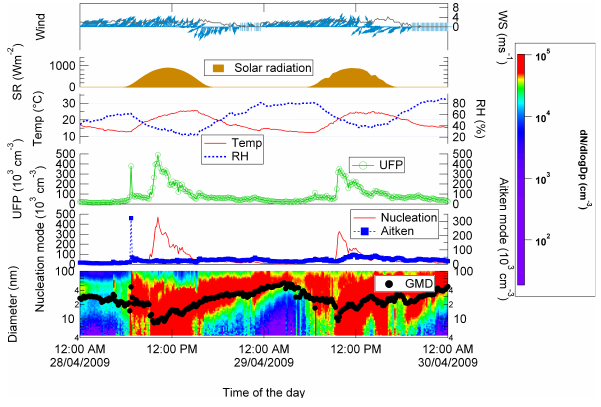
Fig. 10. The nucleation events observed on 28–29 April 2009. From bottom to top, the parameters are: (i) Geometric median diameter (GMD); (ii) Particle number concentration of nucleation and Aitken mode particles; (iii) Particle number concentration of ultrafine par- ticles (UFP); (iv) Temperature and relative humidity; (v) Solar radi- ation; and (vi) wind direction and speed.